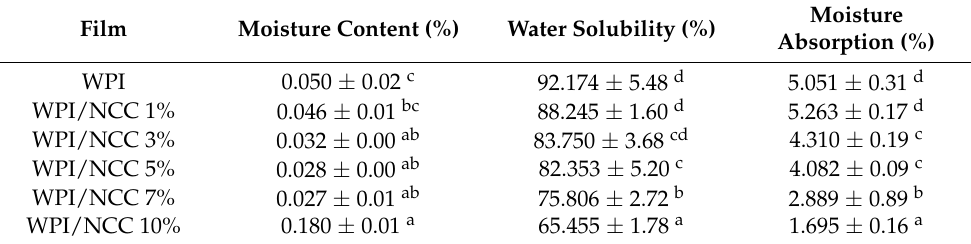
Moisture Absorption (%)